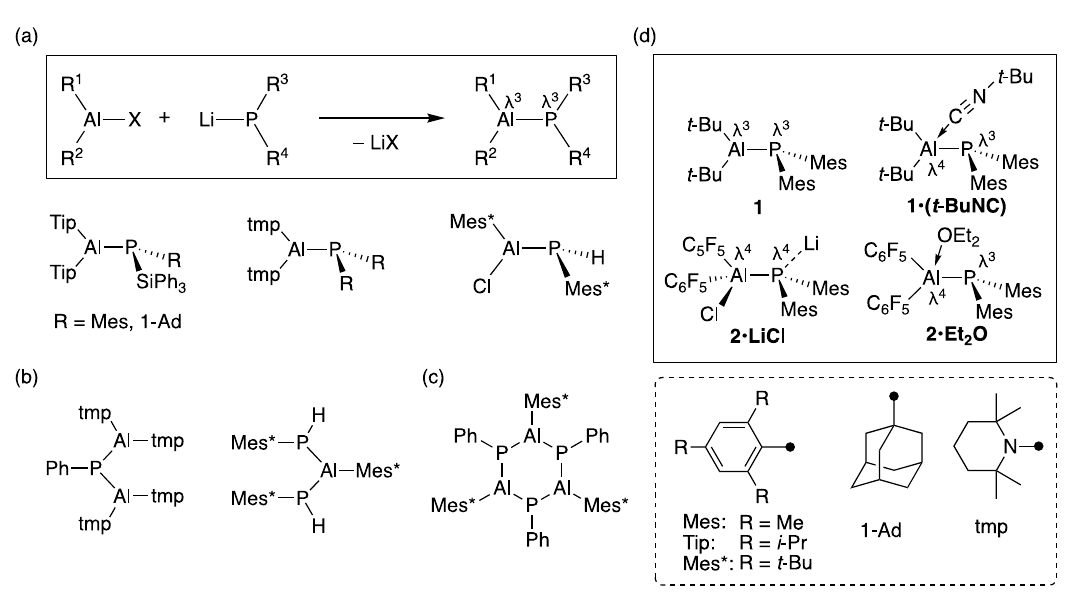
Figure 1. Known phosphanylalumanes. ( a ) Synthetic strategy of λ 3 , λ 3 -phosphanylalumanes. ( b ) λ 3 - Phosphanyl- λ 3 , λ 3 -dialumane and λ 3 , λ 3 -diphosphanyl- λ 3 -alumane. ( c ) Cyclic λ 3 , λ 3 - phosphanylalumane. ( d ) Phosphanylalumane derivatives with carbon protecting groups on Al and P atoms described in this study.